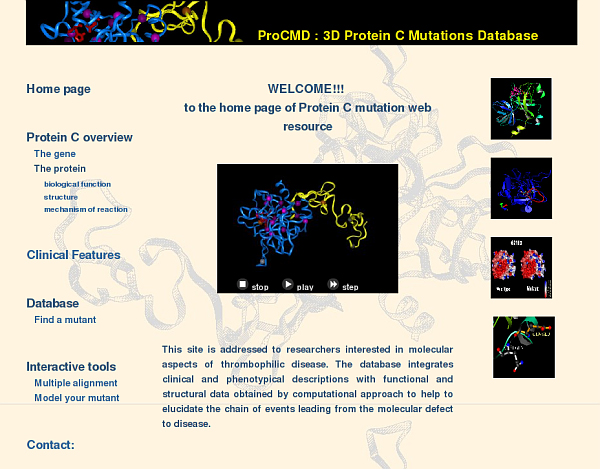
The Home Page of the Database. The database menu is on the left-hand side of the web page. It contains links to general information about gene, protein and clinical features of protein C deficiency, a link to the search in the database, links to mutations analysis tools, to authors correspondence, to a submission form for new mutations and to external web resources. Images are examples of structural details.